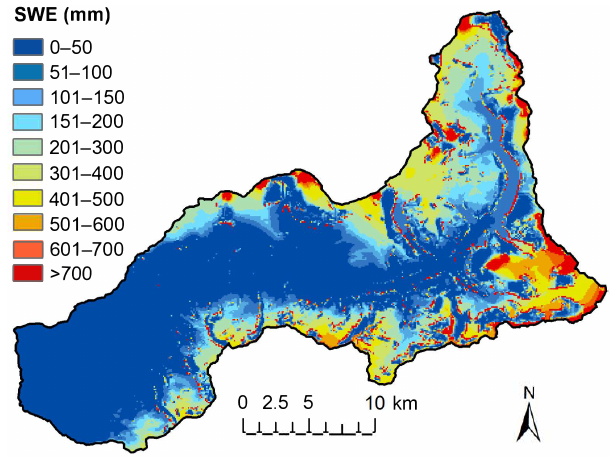
Figure 6. Spatial distribution of ensemble mean annual average snow water equivalent